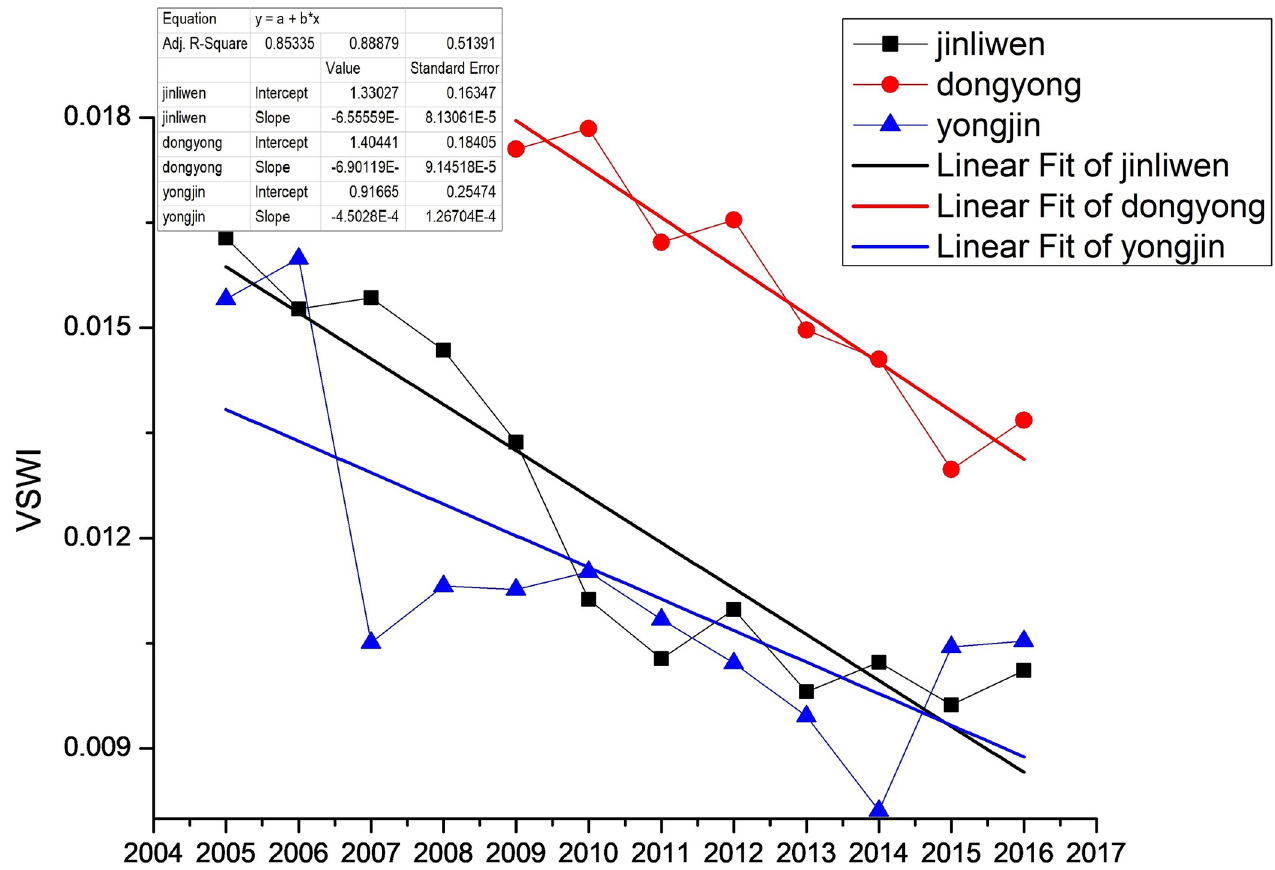
Fig 10. Average value of VSWI in the 1km buffer zone of the three new